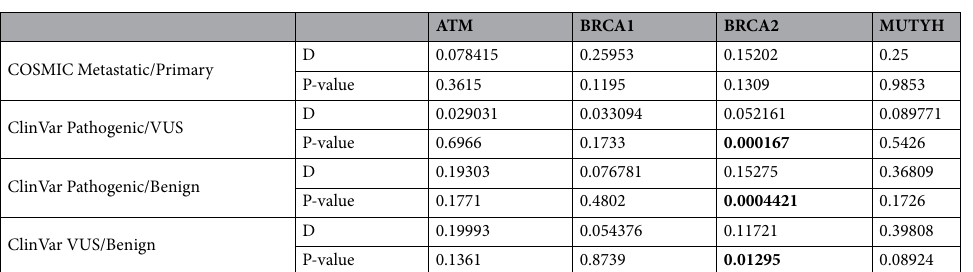
Table 3. Statistical analysis of the distribution of the variants across the protein sequence. Statistical significance of the differences between the density distributions in Fig. 6, as calculated using the GLDEX package (https:// CRAN.R- proje ct. org/ packa ge= GLDEX). Statistically significant differences (shown in bold) are indicated where the P-value is less than 0.05.